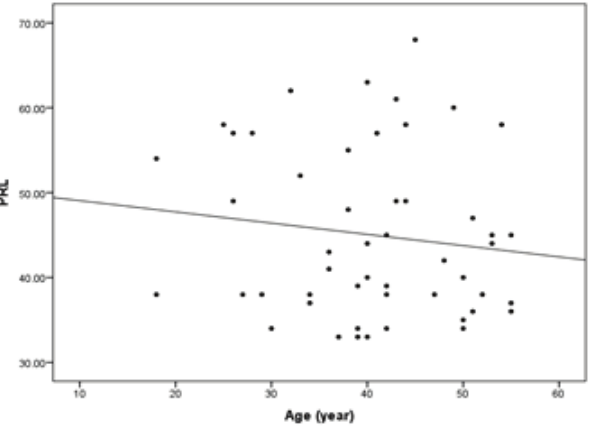
Figure 3 : Correlation of age with prolactin in case group ( R = 0.332, P =